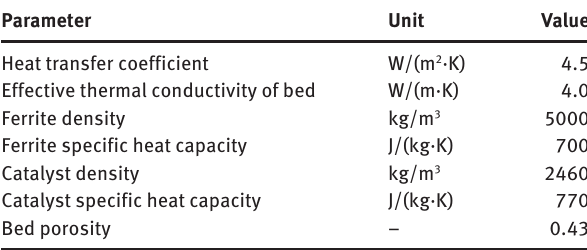
Table 2: Thermophysical reactor